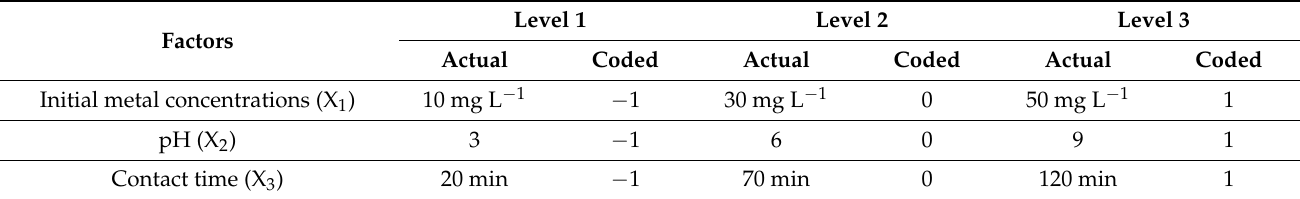
Table 1. Actual and coded factor